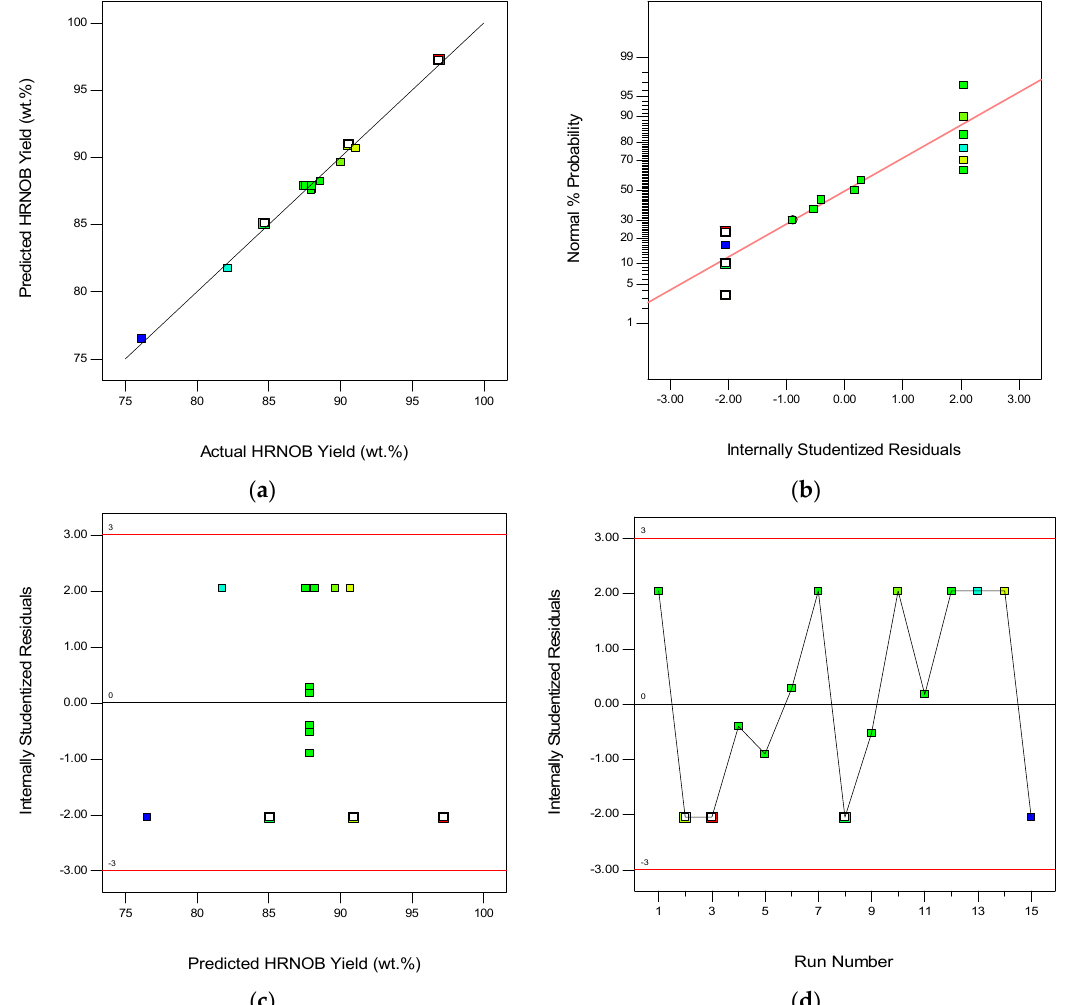
Figure 7. Diagnostic plots of the surface model for HRNOB synthesis.